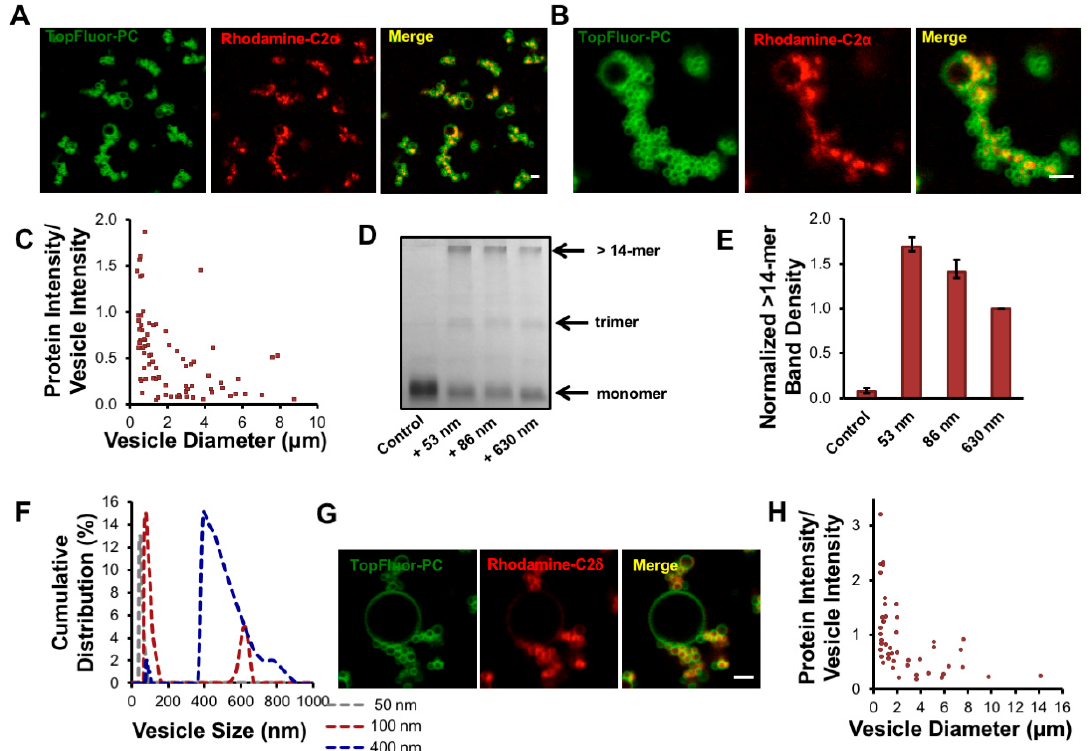
Figure 4. cPLA 2 α preferentially binds to highly curved membranes. ( A , B ) TopFluorPC labeled giant unilamellar vesicles (GUVs) with the lipid ratio (59.8:20:20:0.2) (POPC:POPE:POPS:TopFluorPC) were incubated with 2 μ M cPLA 2 α -C2-E116C labeled with Rhodamine Red ® C 2 Maleimide (Rhodamine-C2 α ) for 30 min then imaged with confocal microscopy. ( C ) Protein intensity bound to lipids was normalized to the vesicle intensity in triplicate for vesicles ranging from 500 nm to 15 μ m in size as specified in the methods section. Vesicle size and intensity values were measured using ImageJ. ( D ) The crosslinking experiment was repeated as stated in Figure 3B with POPC vesicles in buffer containing 20 mM HEPES, 160 mM KCl, 50 μ M CaCl 2 , pH 7.4. ( E ) Band density of the band >14-mer was quantified from D using ImageJ and normalized to the >14-mer band density for 630 nm vesicles. ( F ) The number distribution of the vesicles used in D and E as measured with dynamic light scattering. ( G ) 2 μ M cPLA 2 δ -C2 labeled with Rhodamine Red ® C 2 Maleimide (Rhodamine-C2 δ ) was incubated with GUVs as stated in A. ( H ) Quantification was completed as stated in C. Scale bars are 2 μ m and error bars represent the standard error of the mean.